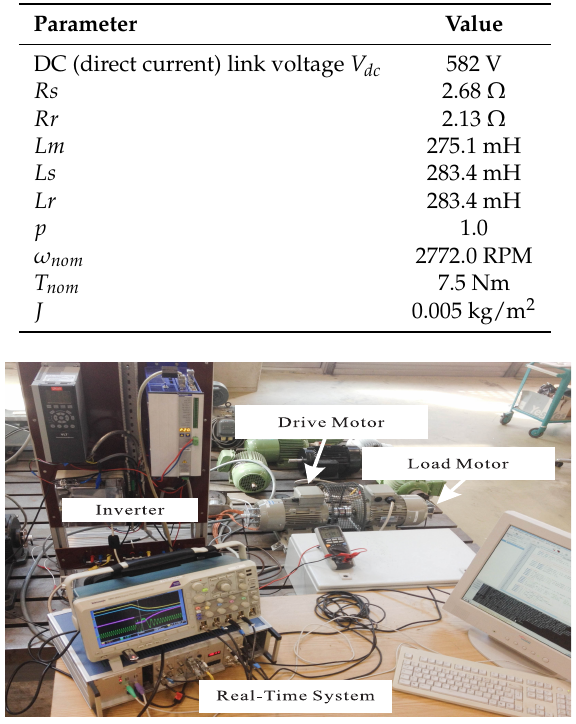
Figure 2. Test bench